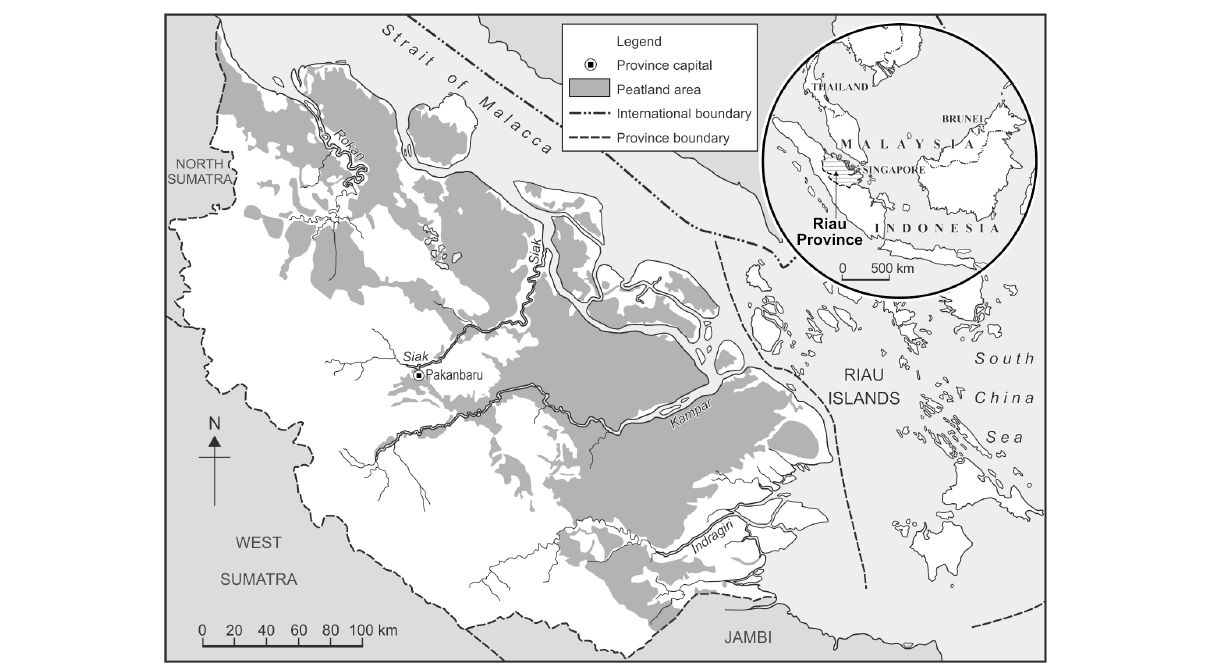
Fig. 1 . Map of Peatlands in Riau,